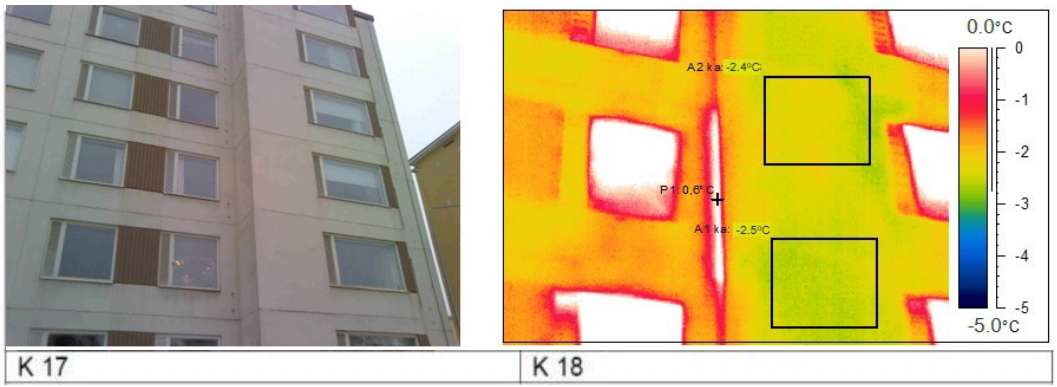
Figure 2. The studied apartments in 2014, measured using a thermal